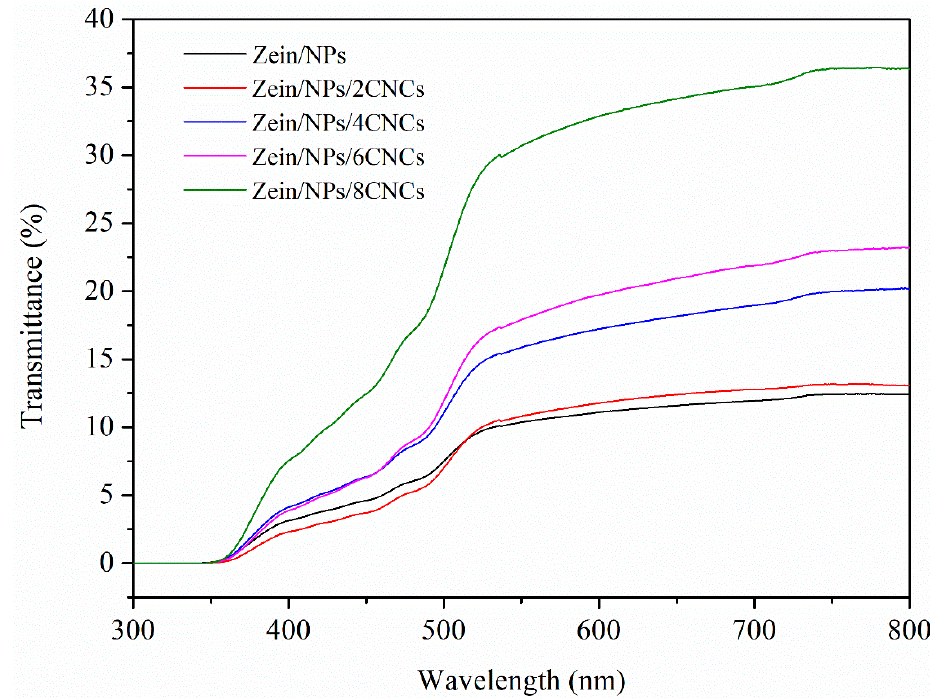
Figure 4. UV-vis light transmittance of Zein/NPs, Zein/NPs/2CNCs, Zein/NPs/4CNCs, Zein/NPs/6CNCs and Zein/NPs/8CNCs.